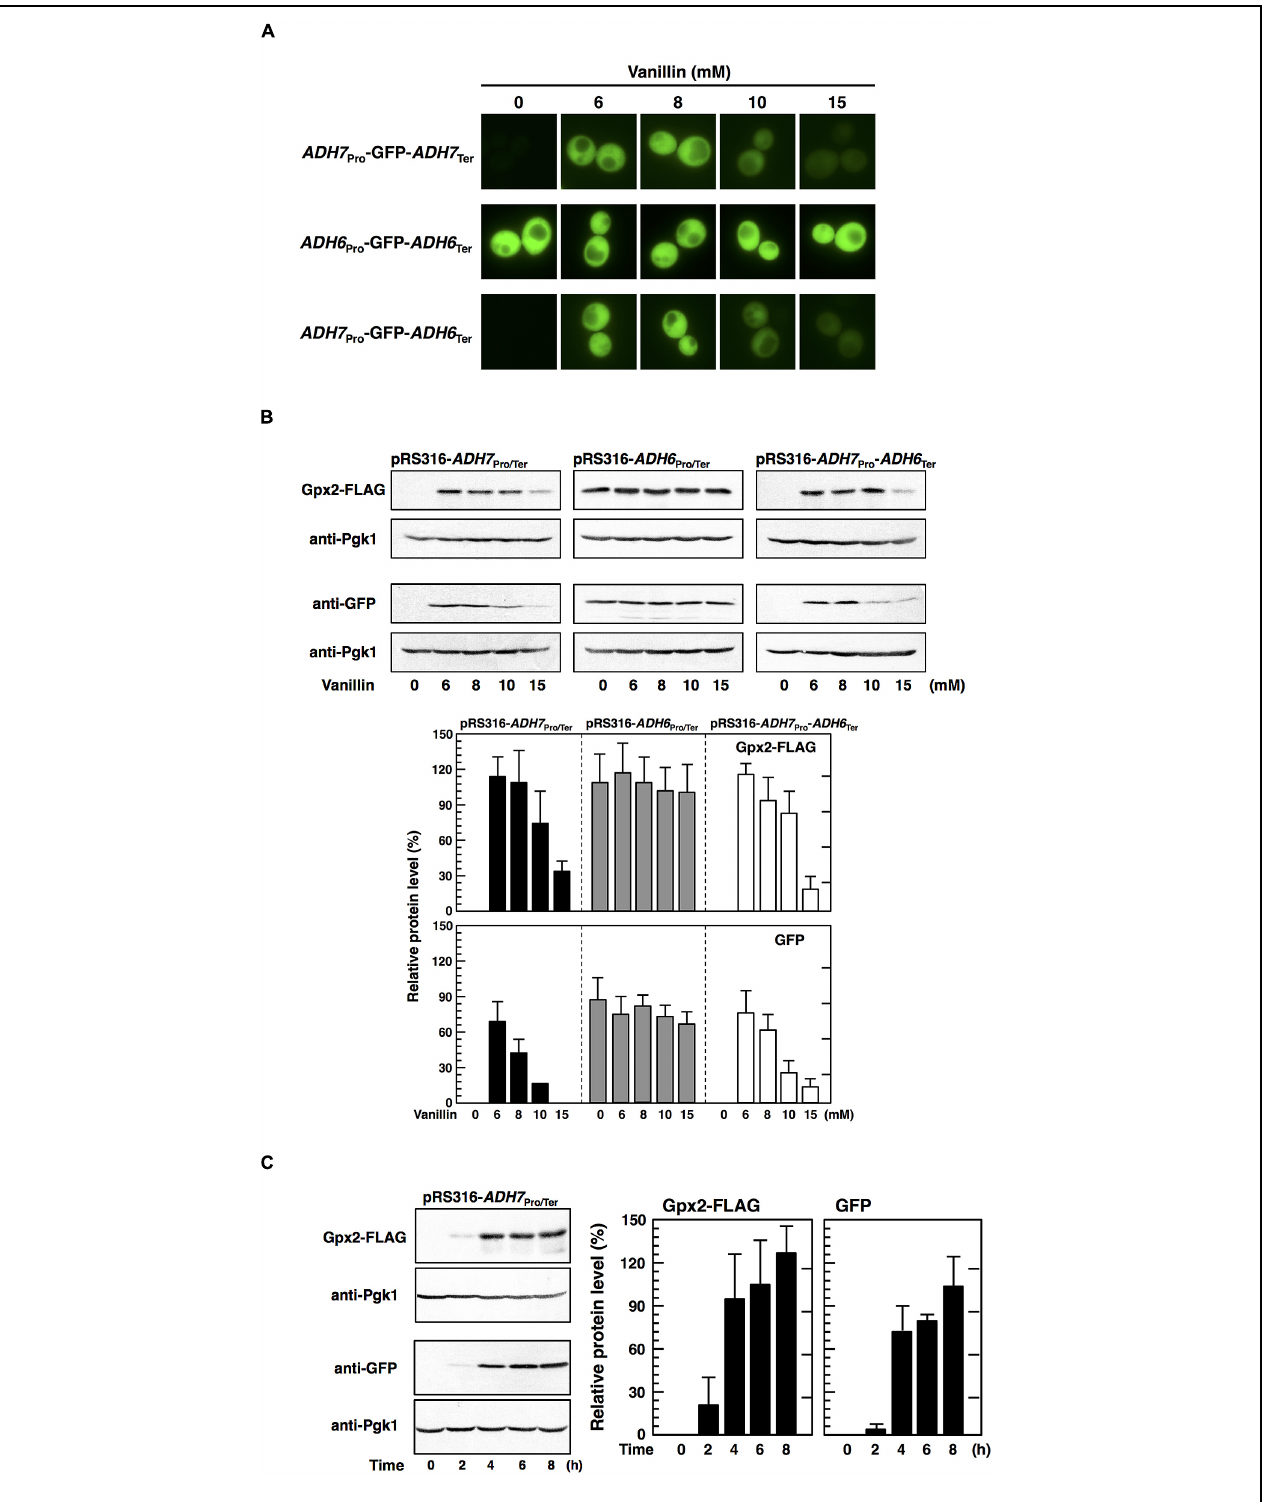
FIGURE 5 | The ADH7 promoter region enables protein synthesis of non-native genes in the presence of high concentrations of vanillin. Cells carrying the pRS316 plasmid series in an exponential phase of growth were treated with vanillin for 60 min (A,B) . (A) Fluorescence microscopic analysis was carried out to monitor the synthesis of GFP. (B) Protein levels of Gpx2 and GFP were determined by western blot analysis. (C) Expression of the GPX2 and GFP genes during the treatment with 15 mM vanillin for 8 h was examined. Protein levels of Gpx2 and GFP were normalized to that of Pgk1 using ImageJ, and the intensity of Pgk1 band of each lane was considered 100%. Data are shown as the mean ± SD of three independent experiments.